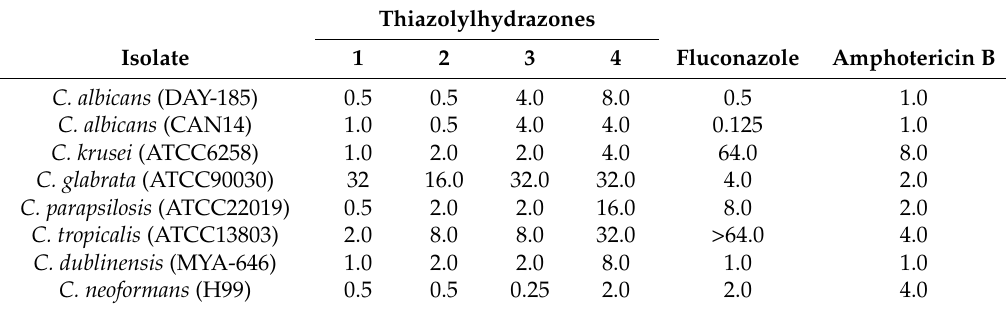
Table 1. MIC * of thiazolylhydrazones compounds against reference isolates of Candida strains and Cryptococcus neoformans